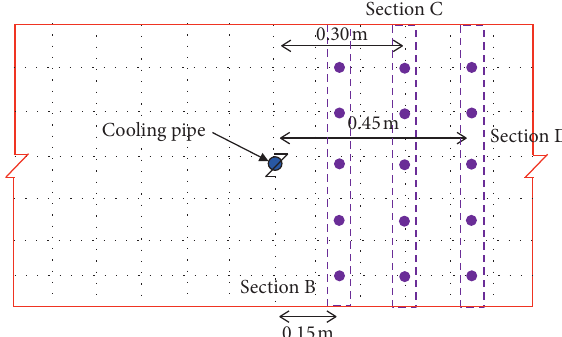
Figure 10: Selected sections of plane